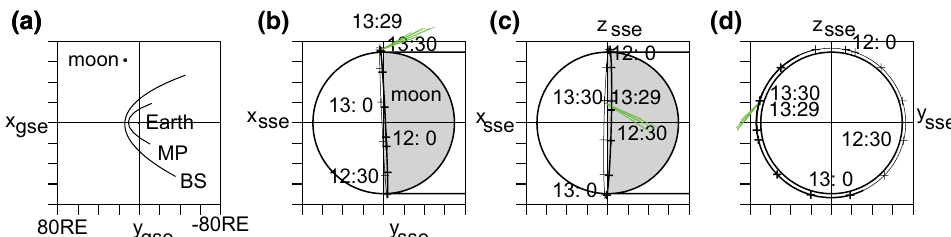
Fig. 2 Kaguya position and magnetic field vectors of limb compression on 1 January 2008. a Position of the moon in the GSE coordinate system, with the nominal bow shock (BS) and magnetopause (MP) of the Earth, and ( b – d ) Position of Kaguya in the SSE coordinate system, projected onto the ( b ) x–y, c x–z and ( d ) y–z planes. Thin-lined curves show that Kaguya was behind the moon. Green bars represent 1-s averaged magnetic field vectors observed by Kaguya during the period from 13:29:20 to